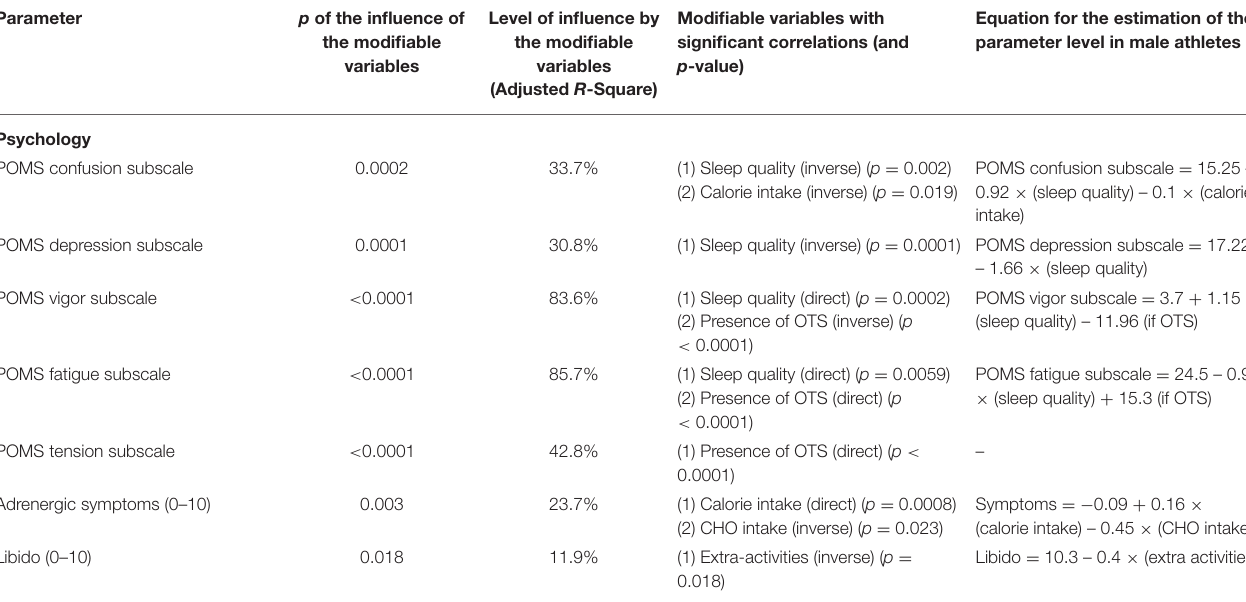
TABLE 4 | Modifiable patterns as independent predictors of moods and feelings (multivariate linear regression